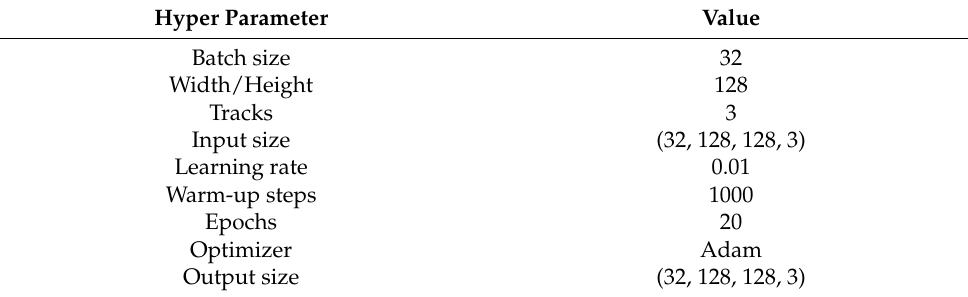
Table 3. Parameters during 3D-DCDAE training.